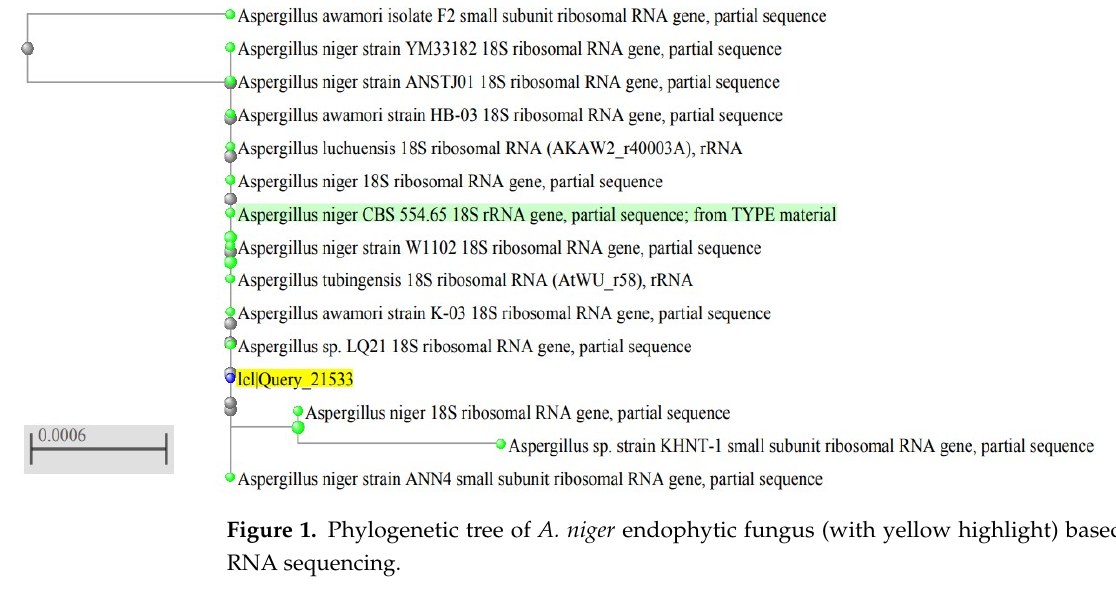
Figure 1. Phylogenetic tree of A. niger endophytic fungus (with yellow highlight) based on 18srRNA sequencing.